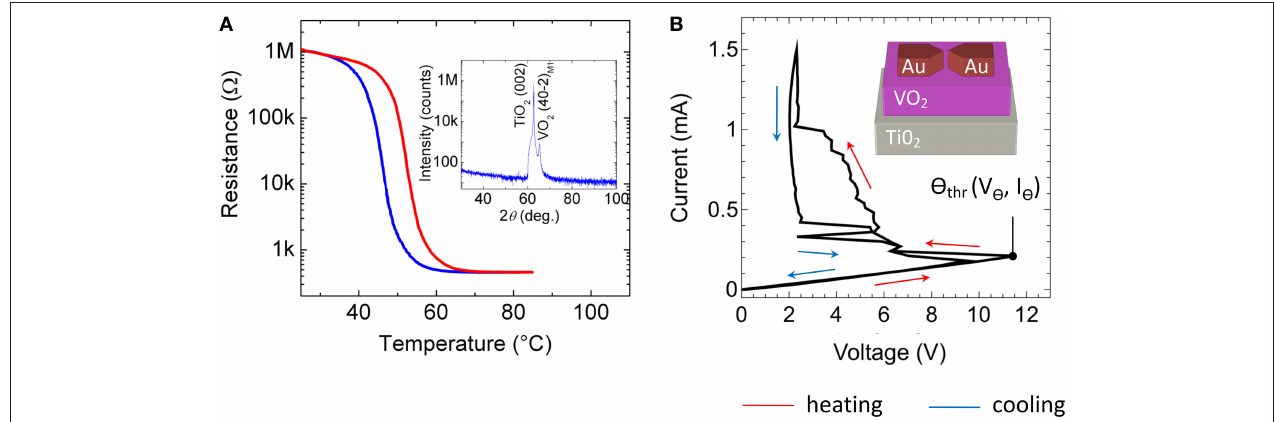
FIGURE 3 | Electrical characteristics of the VO 2 device: (A) Resistance versus temperature characteristic. Inset of (A) : X-ray 2 θ - ω scan of the VO 2 film on a TiO 2 (001) substrate measured with Cu K α radiation. The observed peaks correspond to TiO 2 (002) and to VO 2 (40-2) M1 (insulating phase, space group P2 1 /c, a M 1 = 5.743 Å, b M 1 = 4.517 Å, c M 1 = 5.375 Å, and β M 1 = 122.618 ◦ ) (B) Current voltage characteristic of a lateral VO 2 device together with a schematic sketch of the device structure. In all sub-figures indicating the red arrows the heating cycle and the blue arrows showing the cooling